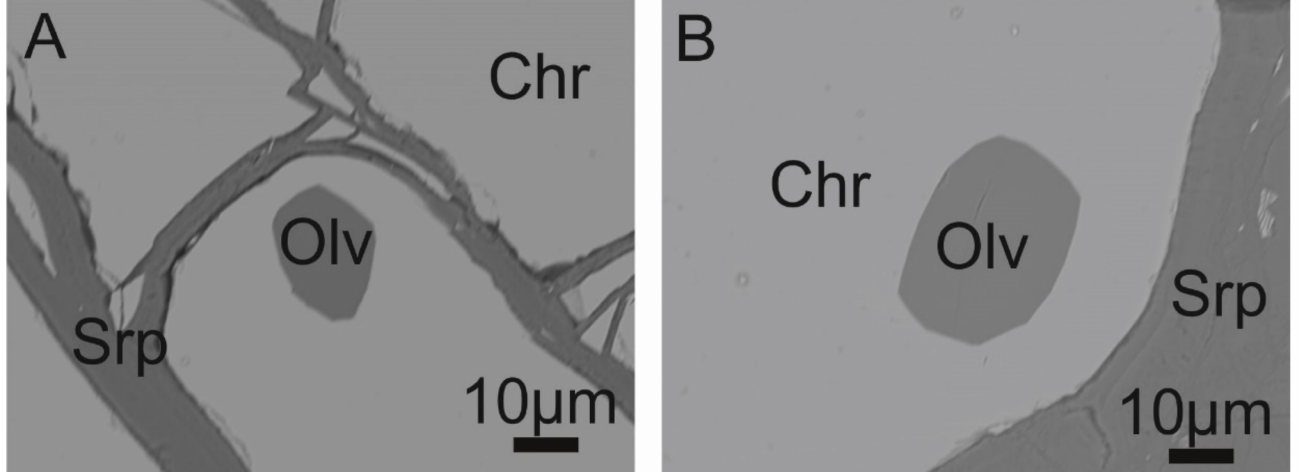
Figure 7. BSE images of olivine enclosed in high-Cr chromite and serpentine found in the matrix of